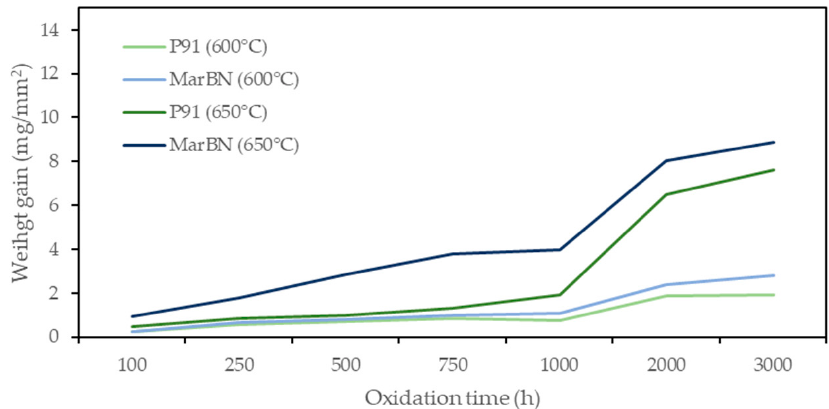
Figure 1. Oxidation weight gain curves of P91 and MarBN steels in a simulated humid atmosphere with ∼ 10% water vapour at 600 °C and 650 °C.